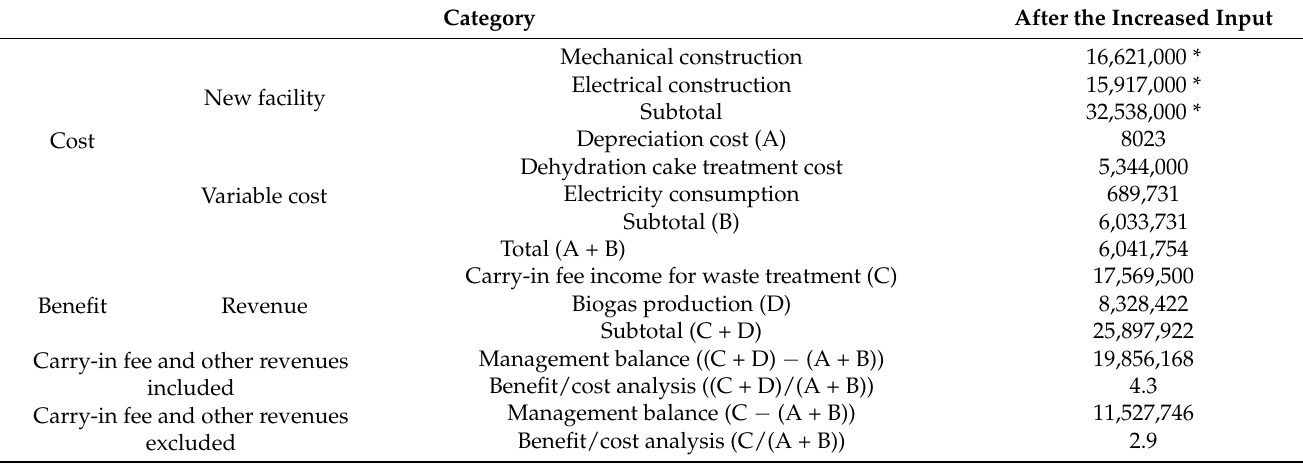
Table 8. Results from the economic analysis of the anaerobic digester of the wastewater treatment plant. Category After the Increased